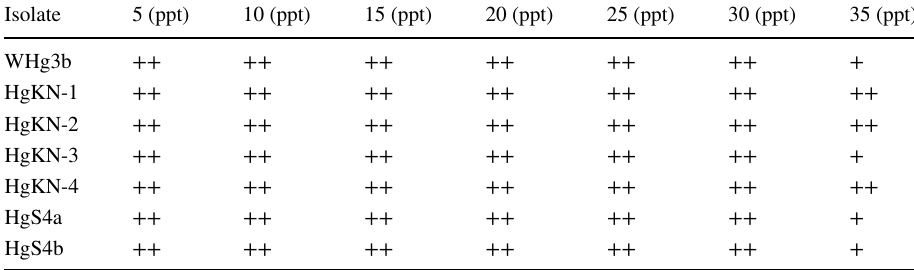
+ denotes growth, ++ denotes dense